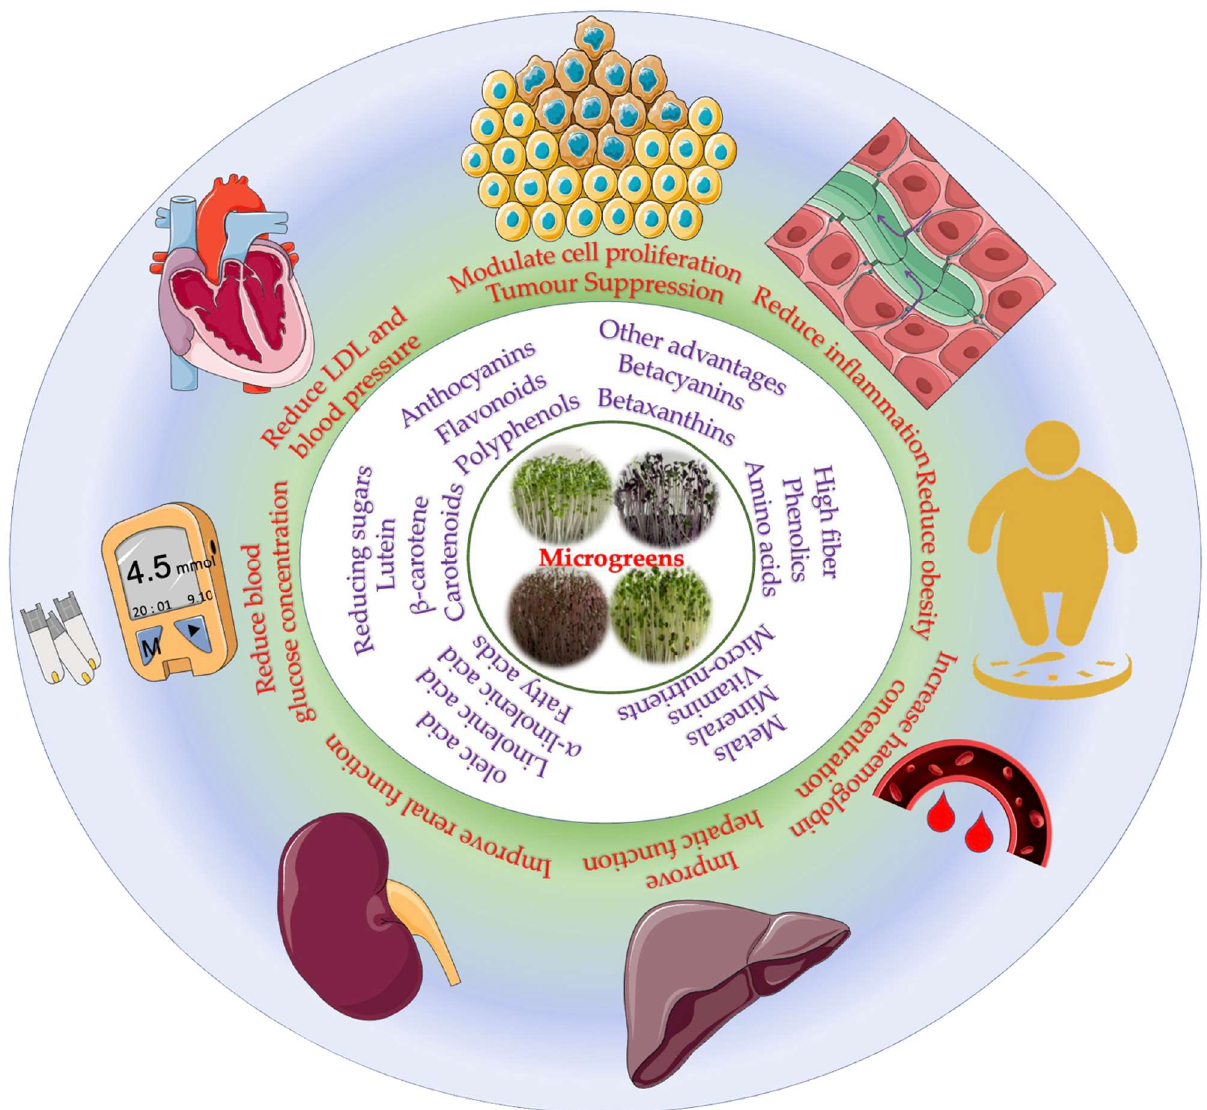
Figure 2. Overview of health benefits of microgreens.